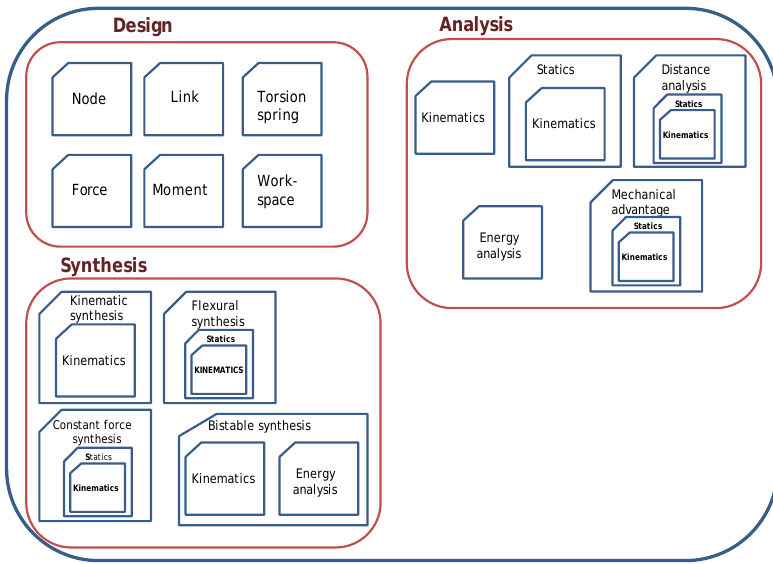
Figure 3. DAS 2D class structure is shown. The main classes can be categorized under three different groups. TS4